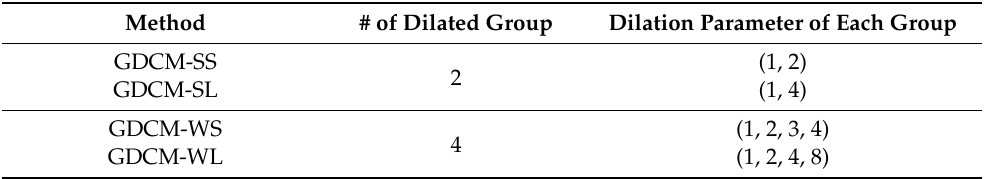
Table 3. Comparison of the number of dilated groups and dilation parameters of each group per method. # means “the number”.